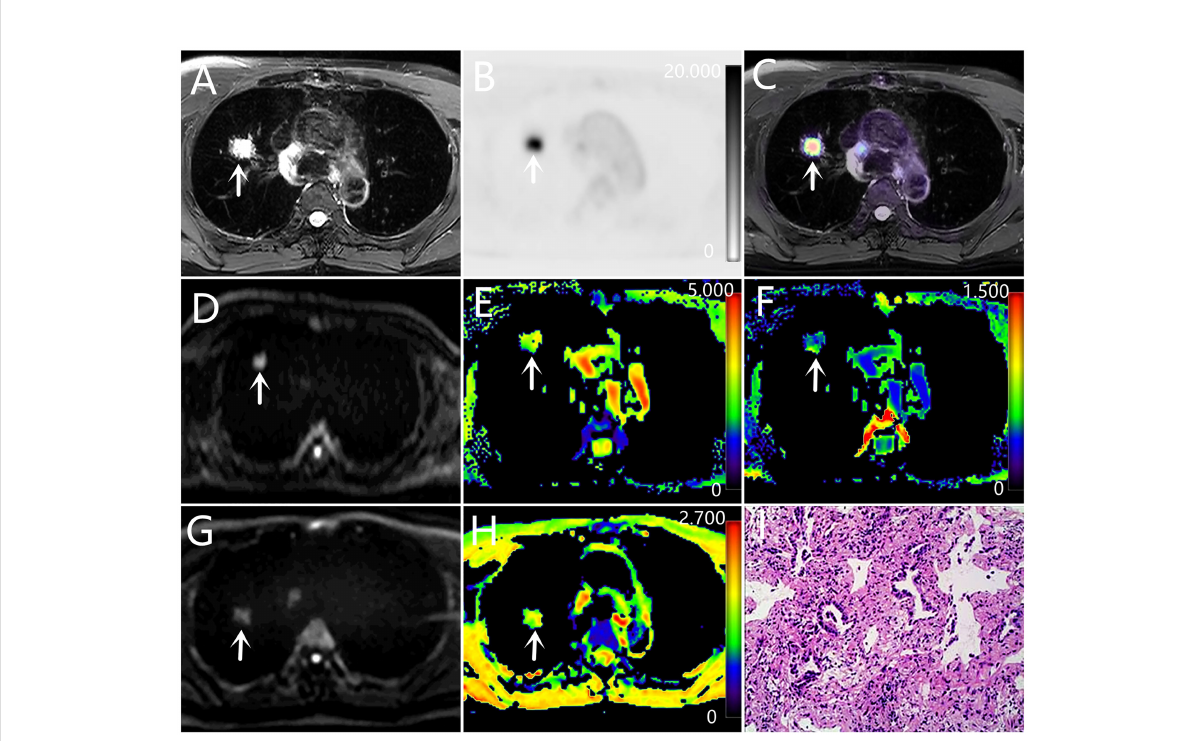
FIGURE 2 A-H: a 63-year-old male with adenocarcinoma (poorly differentiated). (A) T 2 WI, (B) PET original image, SUV max = 11.94, MTV = 1.69, TLG = 12.47, (C) PET and T 2 WI fusion map, (D) DKI original image (b=1000 s/mm 2 ), (E) MD pseudo-color map, MD = 2.54×10 -3 mm²/s, (F) MK pseudo- color map, MK = 0.44 (G) DWI original image (b=1000 s/mm 2 ), (H) ADC pseudo-color map, ADC = 1.43×10 -3 mm²/s, (I) hematoxylin and eosin (H&E) staining